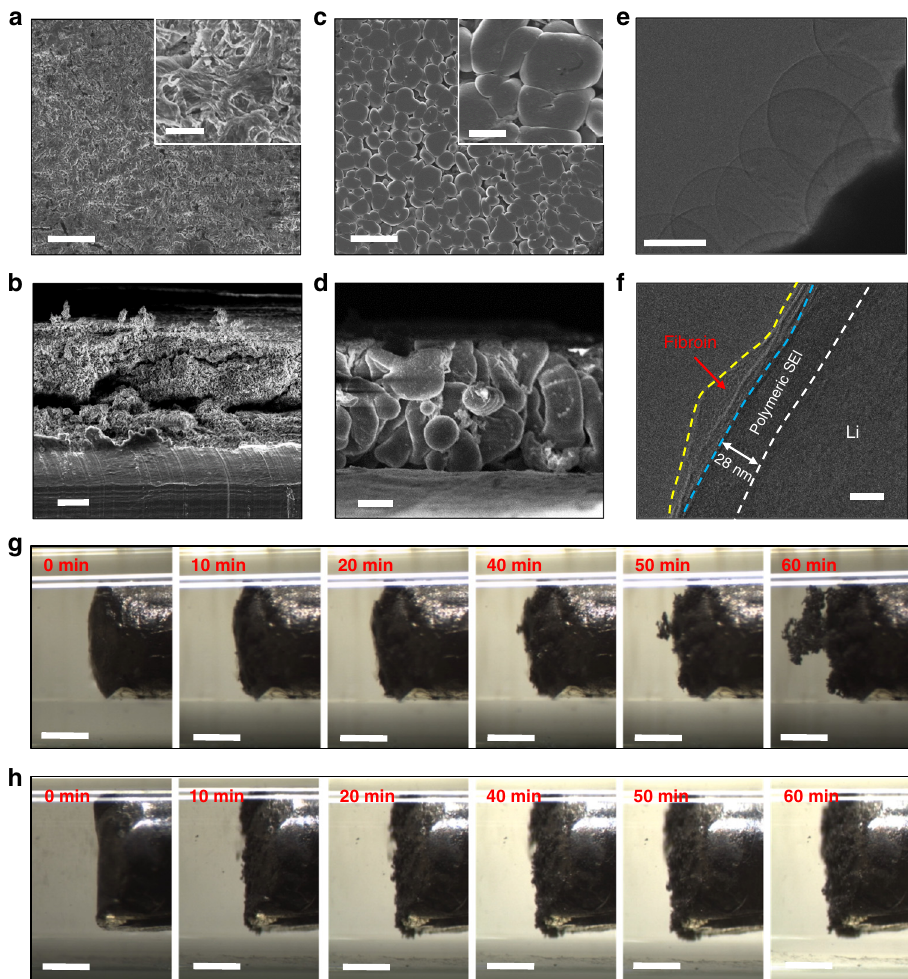
Fig. 2 Characterization of Li deposition in ether-based electrolyte with fi broin additive. a , b Top-view ( a ) and cross-section ( b ) SEM images of Li metal anodes cycling in the cells with blank (i.e. no fi broin) electrolyte. c , d Top-view ( c ) and cross-section ( d ) SEM images of Li metal anodes cycling in the cells with fi broin additive in the electrolyte. The insets in ( a ) and ( b ) are the corresponding high-magni fi cation SEM images. Scale bars, ( a – d ) 20 µ m and inserts in ( a , c ) 5 µ m. e , f Low-resolution ( e ) and high-resolution ( f ) cryo-EM images of Li deposit in the ether-based electrolyte with fi broin. Scale bars, ( e ) 1 µ m and ( f ) 20 nm. The white line delineates the boundary between metallic Li and SEI. The blue line delineates the boundary between adsorbed fi broin and SEI. The yellow line delineates the boundary between adsorbed fi broin and electrolyte. g , h In situ observations of Li deposition behavior in the glass capillaries fi lled with the blank electrolyte ( g ) and the electrolyte with fi broin ( h ) at a current density of 3 mA cm − 2 . Scale bars, ( g , h ) 500 µ